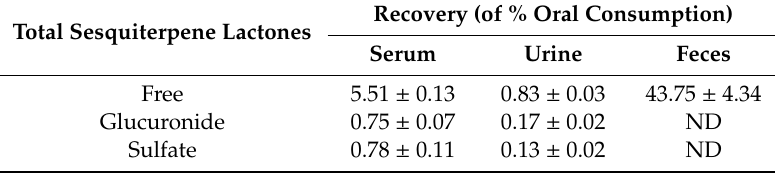
Table 2. Recovery of total sesquiterpene lactones in blood, urine, and feces over 24 h in 16 healthy adults after Brussels / witloof chicory consumption a .